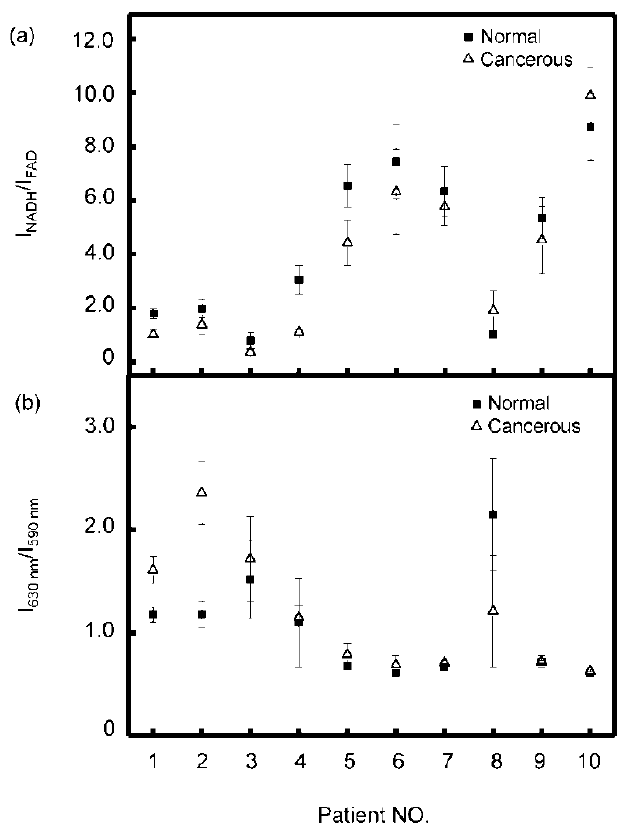
Figure 4. Scatterplot of the average ratio of ( a ) I NADH / I FAD and ( b ) I 630 nm / I 590 nm for the normal (solid square) tissues and cancerous tissues (hollow triangle) from the ten lung cancer patients.